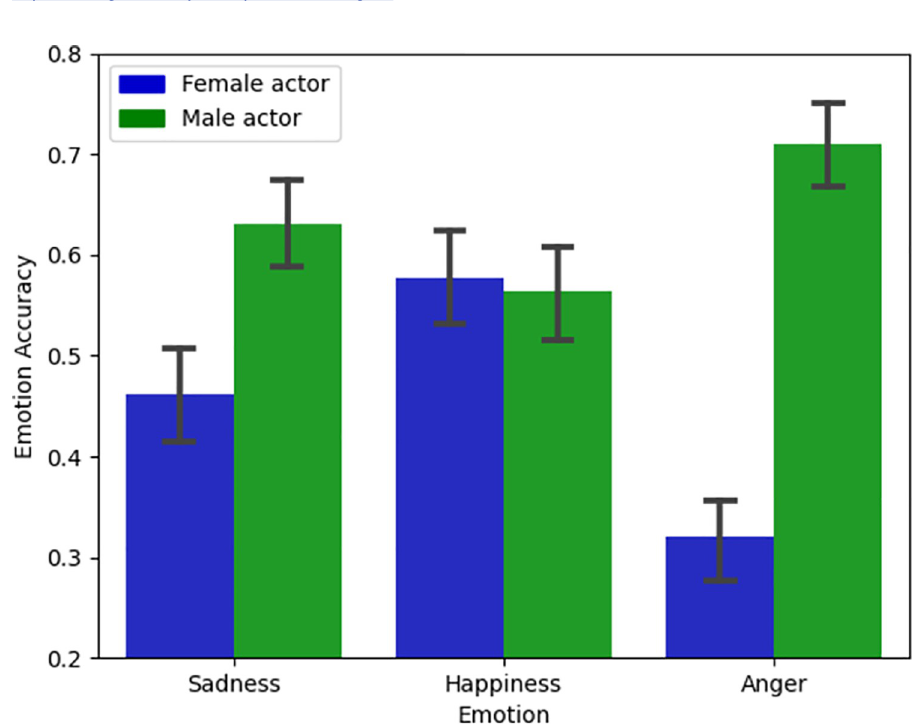
Fig 3. Accuracy and gender results. Emotion Recognition Accuracy depending on actor Gender and Emotion Categories. Y-axis represents a truncated scale, and error bars represent 95% confidence intervals.